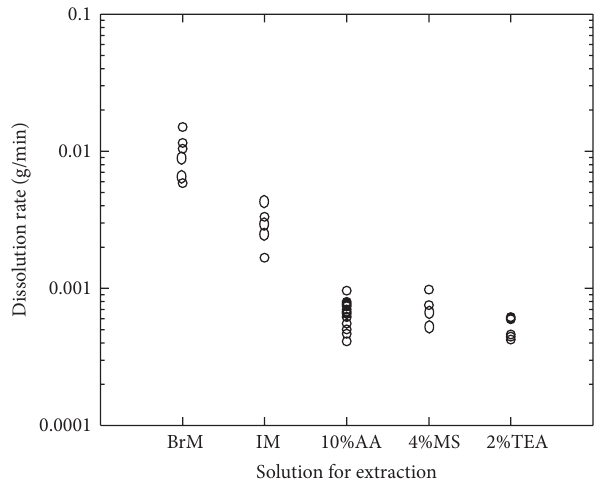
Figure 2: Dissolution rates of metal samples during the chemical (using 5 v/v% bromine-methanol and 14 w/v% iodine-methanol) and electrolytic (using 10% AA, 4% MS, and 2%TEA electrolytes) extractions.